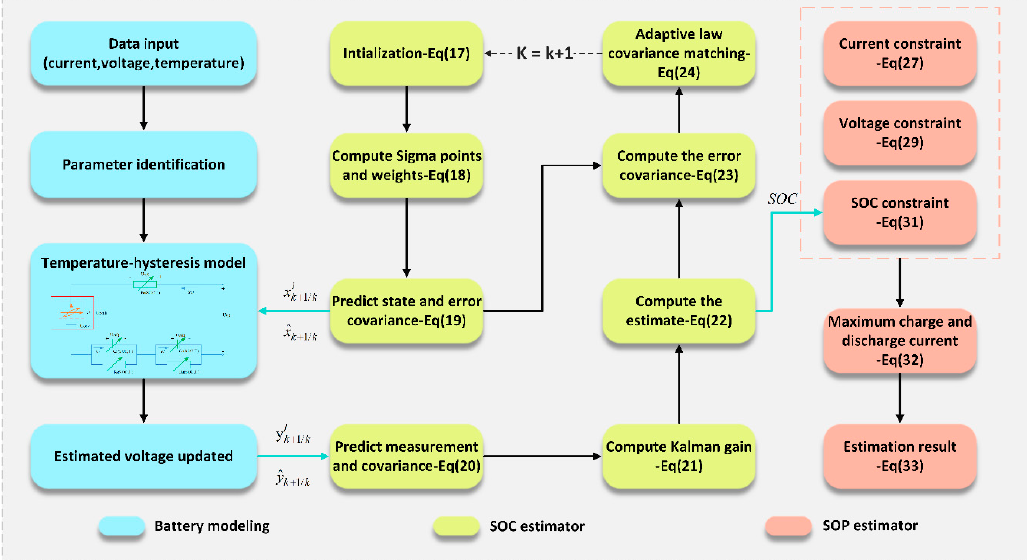
Figure 6. The flowchart of the model-based SOC and state of power (SOP) estimator.